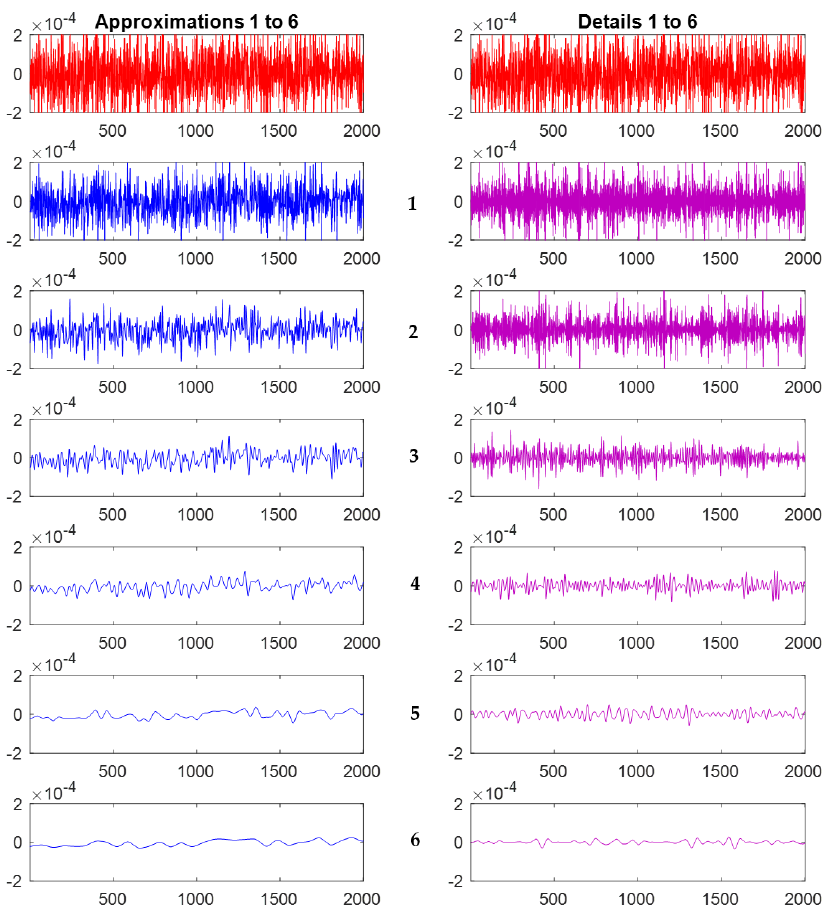
Figure 4. Sample wavelet decomposition for the first 6 out of 10 approximations ( left ) and details of the vibration time signal ( right ) at 300 rpm, feed = 0.0635 mm/rev, and D.O.C. = 0.46 mm.